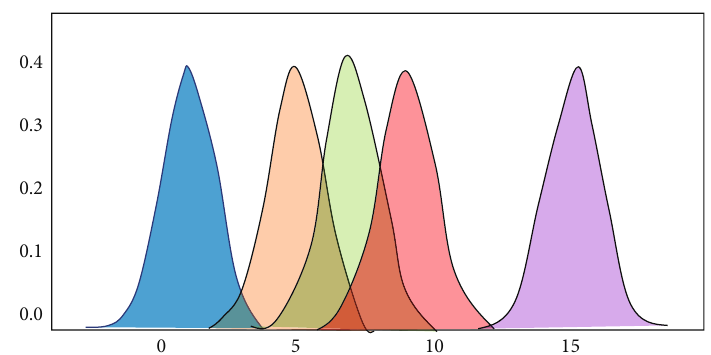
Figure 7: Classi fi cation results of three features with di ff erent Gaussian mixture